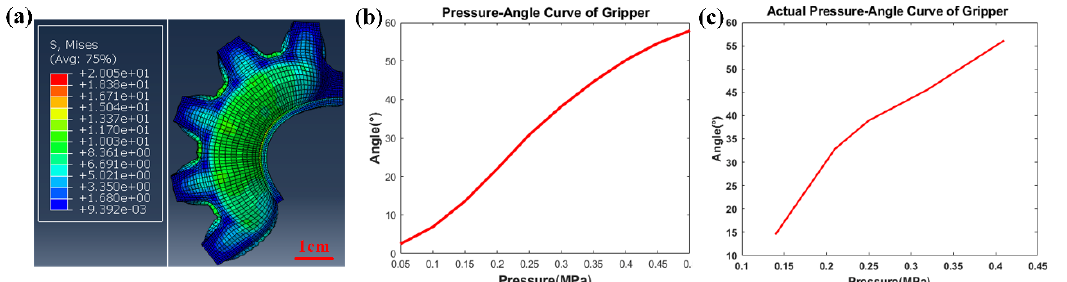
Figure 4. Numerical simulation and actual experiment of the gripper. ( a ) Deformation of the gripper when load is set as 0.45 MPa. ( b ) Pressure-angle curve of the gripper by numerical simulation. The pressure ranges from 0.05 MPa to 0.5 MPa. ( c ) Pressure-angle curve of the gripper by actual experi- ment.